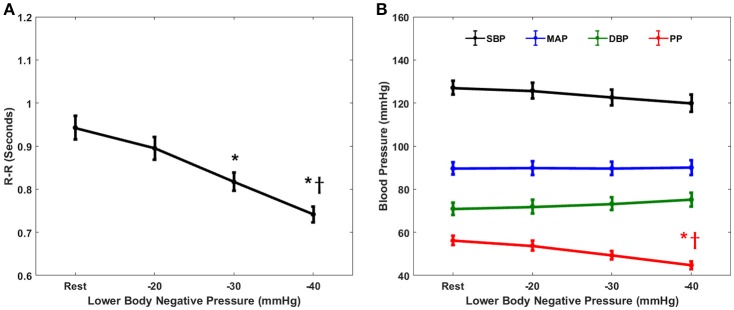
The response of cardiovascular parameters to graded lower-body negative pressure. R-R intervals (A) reduced significantly both at −30 (p = 0.001) and −40 (p < 0.001) mmHg LBNP compared to rest. Pulse pressure (B) reduced significantly (p = 0.001) at −40 mmHg compared to rest. Additionally, both R-R intervals (p < 0.001) and pulse pressure (p = 0.02) reduced significantly at −40 mmHg LBNP compared to −20 mmHg LBNP. The systolic blood pressure (B), diastolic blood pressure (B), and the mean arterial pressure (B) did not change (p = 0.50, p = 0.79, and p = 0.99, respectively) in response to graded lower-body negative pressure, * and †represents significant change (p < 0.05, post-hoc result) compared to rest and −20 mmHg, respectively.